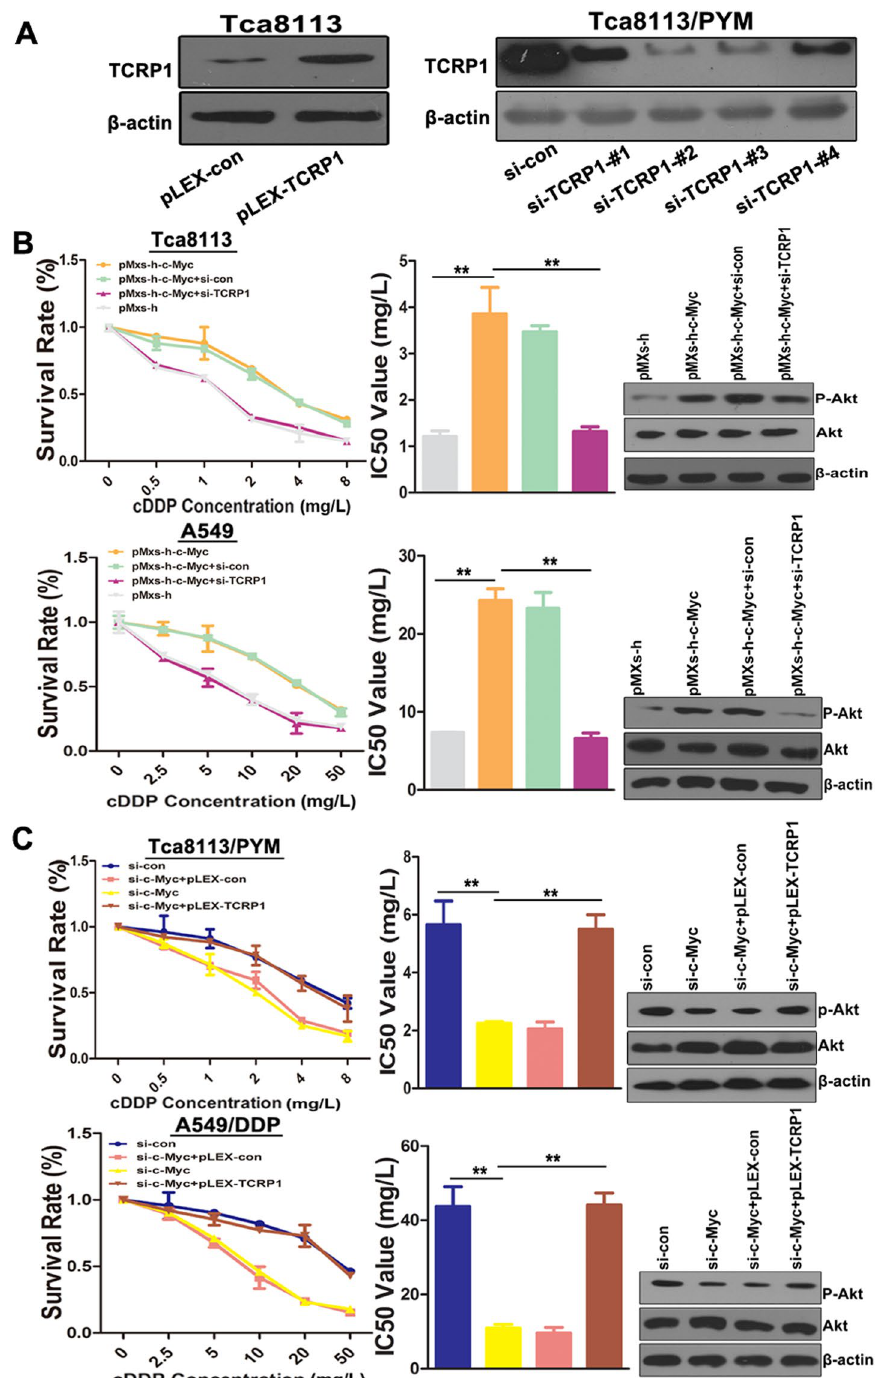
Figure 2. The c-Myc-TCRP1 axis inhibites sensitivity of tongue and lung cancer cells to cDDP. ( A ) Transfected plasmid pLEX-TCRP1 and its control into Tca8113 cells, meanwhile transfected siRNAs targeting TCRP1 and its control into Tca8113/PYM cells, 48 h later, western blot assay was used to measure TCRP1 expression levels in these different treated cells. ( B ) Overexpressed c-Myc together with silencing TCRP1 in parative cells Tca8113 and A549, ( C ) Silencing c-Myc together with over-expressed TCRP1 in chemoresistance cells Tca8113/PYM and A549/DDP, all these cells and each control group were treated with cDDP for 72 h, and the survival rate of these cells were detected by MTS assay, western blot assay was used to measure Akt activation. ** P <